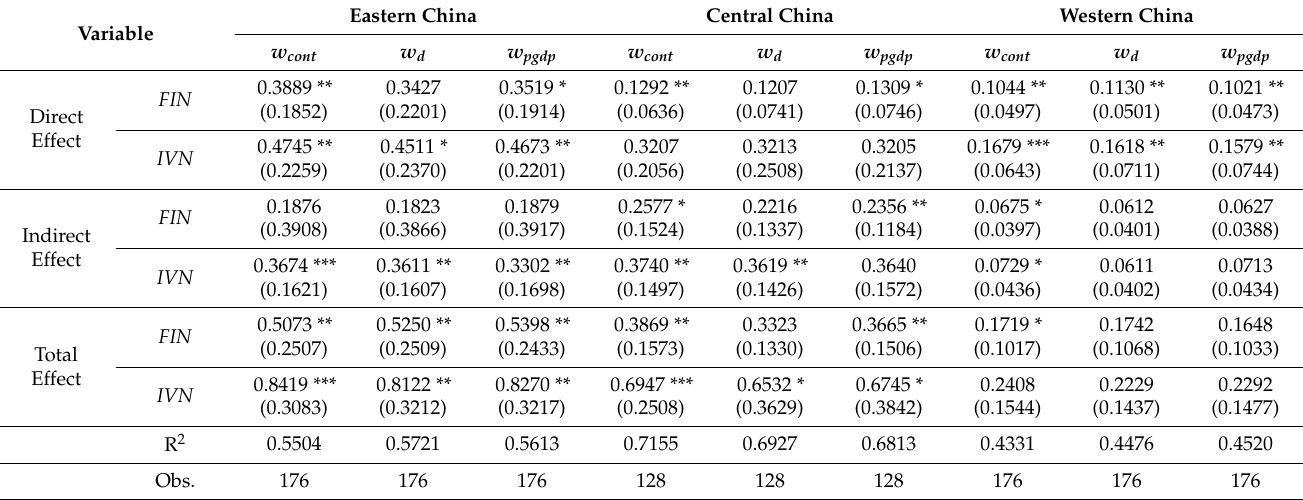
Table 4. Estimated results by region from 2000 to